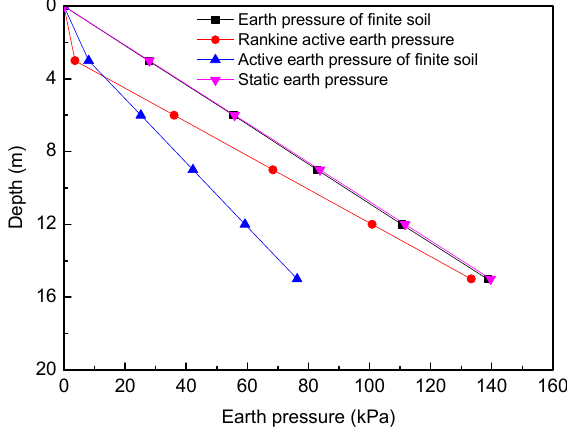
Figure 9. Earth pressure.